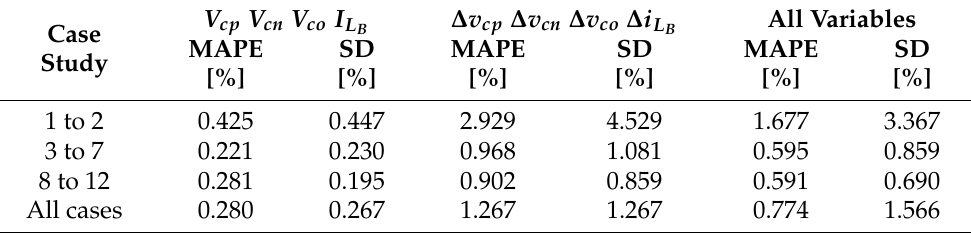
Table 9. Percentage error statistical results of the proposed converter with PSIM simulator.